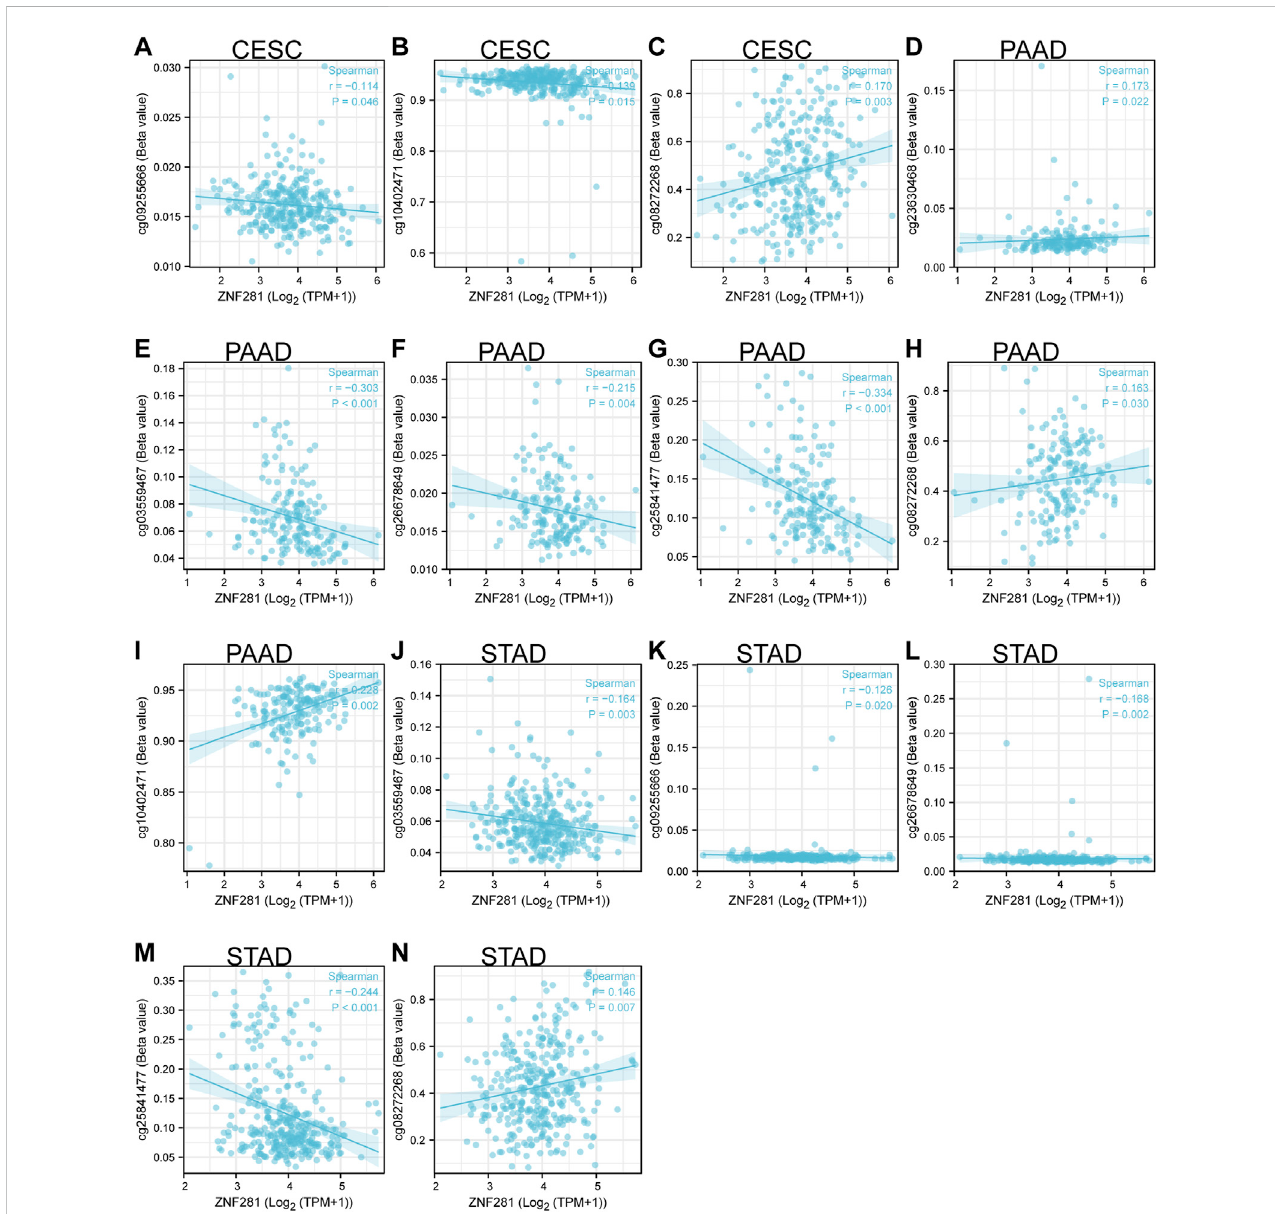
FIGURE 5 ZNF281 -associated DNA methylation sites in CESC, PAAD, and STAD. (A – C) Methylation sites in the TSS region of ZNF281 in CESC, (D – I) methylation sites in the TSS region of ZNF281 in CESC, and (J – N) methylation sites in the TSS region of ZNF281 in